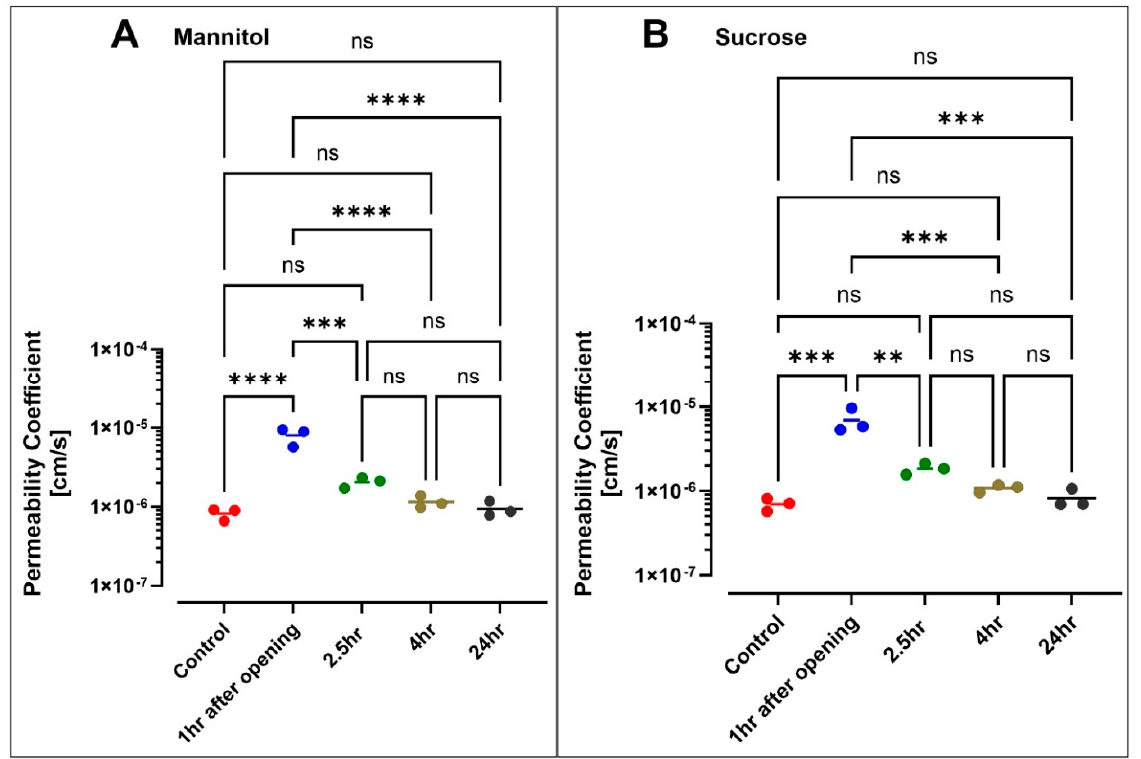
Figure 6. Evaluation of the barrier integrity of the BBB chip after exposure to hyperosmolar mannitol for 10 min. Monitoring the permeability of sucrose ( A ) and mannitol ( B ) over a 24 h window after exposure to hyperosmolar mannitol revealed a significant increase in their respective permeability values at 1 h post-opening. Sucrose and mannitol permeability then returned progressively to normal over the 24 h period ( n = 3 biological replicates). ** p < 0.01, *** p < 0.001, and **** p < 0.0001 assessed by one-way ANOVA, followed by Tukey’s multiple comparisons tests.